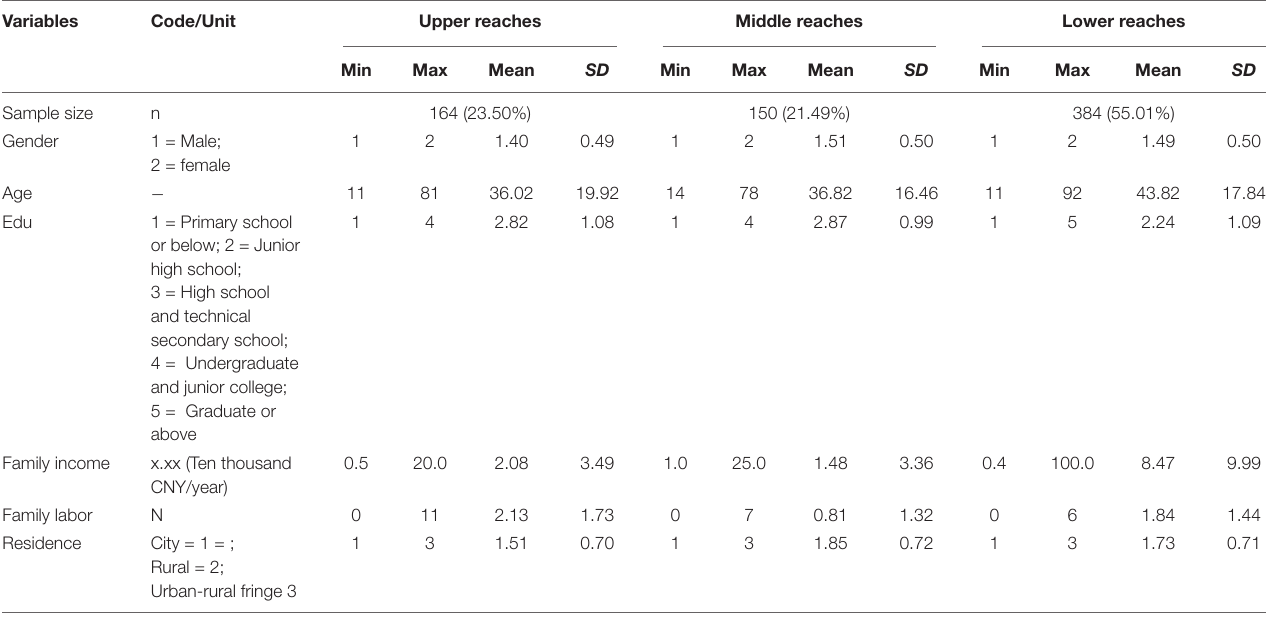
TABLE 3 | Socioeconomic characteristics of respondents.